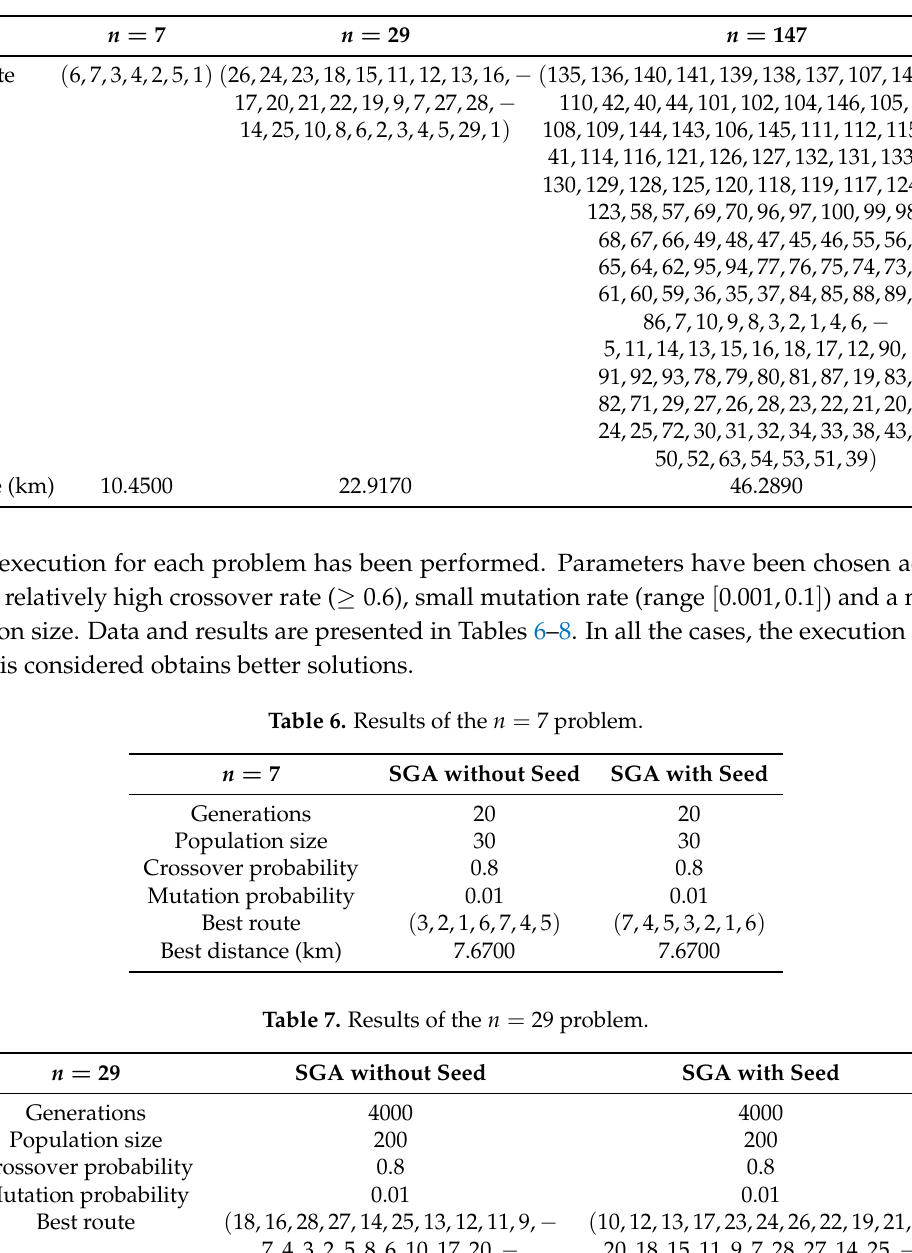
Table 5. Average distance route ( n = 7) and actual routes ( n = 29, n = 147).